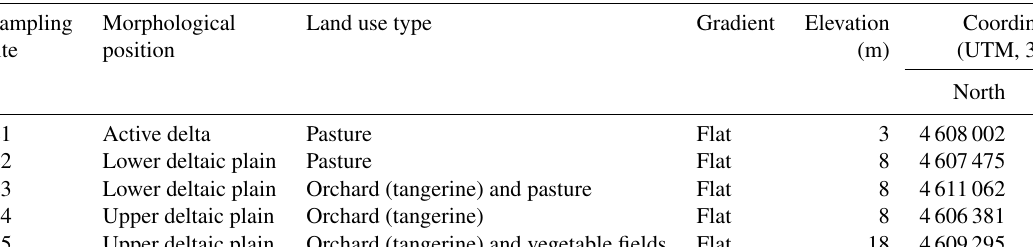
Table 1. Morphological position, land use type and location of sampling sites.